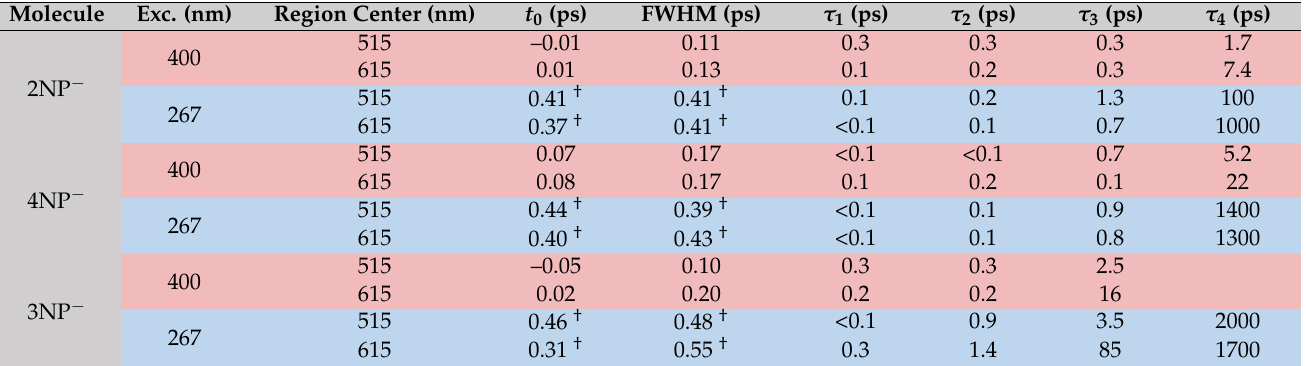
* The listed values from the probe-dependent TA data best fits roughly correspond to the features reported by global analysis (see Table 1 above); however, the convolution of features due to spectral overlap hinder the accuracy of such an analysis. Red and blue shades highlight the retrieved parameters of transient electronic states/species after 400 and 267 nm excitations, respectively, for three nitrophenolates in water. Blank boxes indicate the absence of corresponding time constants. The fitting parameters with more detailed values can be found in Table S1, along with the probe-dependent fitting parameters for three nitrophenolates in methanol after 267 nm excitation, for comparison. Five datasets across each complete TA measurement (see Figure S8, for example) were averaged and a least-squares fit was performed to yield the time constants in this table for a systematic comparison among three regioisomers of nitrophenolates under 400 and 267 nm excitations. † These fitted time zero ( t 0 ) and full-width at half-maximum (FWHM) values are noticeably larger due to the delayed onset of the TA signal’s maximal intensity magnitude following 267 nm excitation versus 400 nm excitation (see Figure 2d–f versus Figure 2a–c). Accordingly, the blue traces consistently exhibit a delayed peak maximum on the sub-ps timescale versus the red trace in all the panels of Figure 3 for all three nitrophenolates in water. Note that the differences go beyond the variation in cross-correlation times: ~120 fs with 400 nm excitation (compressed) and <300 fs with 267 nm excitation (uncompressed). Due to sample dispersion, the cross correlation (and hence, the effective temporal resolution of the experiments) could be wavelength-dependent even for a compressed probe pulse; yet, the best-fit t 0 and FWHM values in this table around 515 and 615 nm probe wavelengths are largely similar. Therefore, the focus here is not the exact numerical values or profiles for the cross-correlation time across a broad spectral window, but the systematic fitting and comparative analysis between the electronic dynamics (e.g., onset and decay) as a function of two excitation wavelengths (i.e., 400 and 267 nm in this